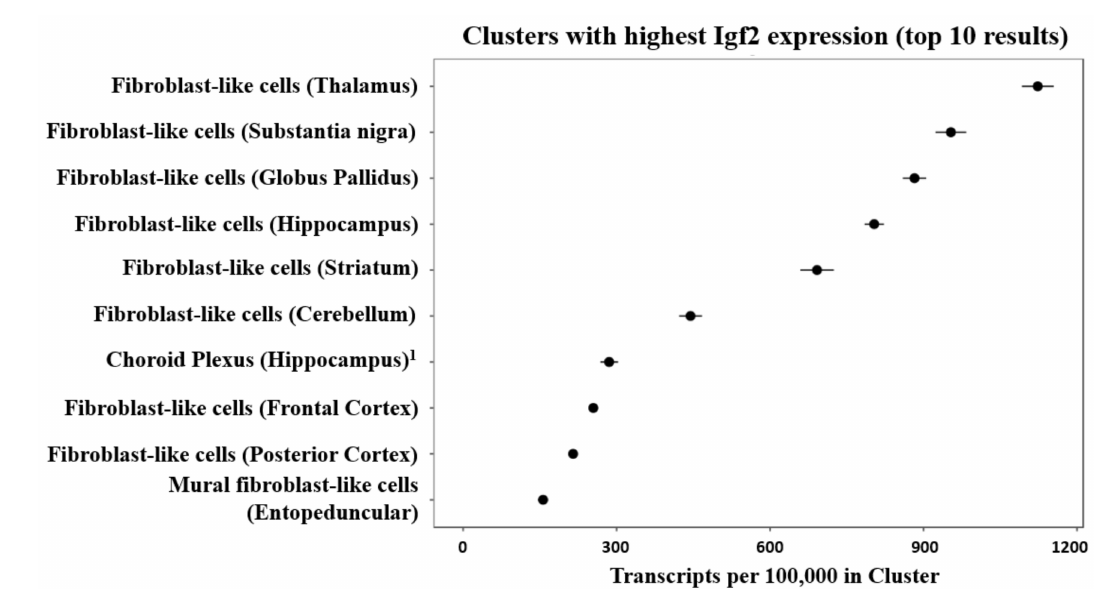
Figure 3. Cell clusters of the mouse brain showing the highest expression of Igf2 mRNA after single-cell sequencing from 9 mouse brain regions. The figure was generated by DropViz [68,69] and slightly modified. 1 It was noted that small fractions of choroid plexus were sampled from ventricle-adjacent regions including hippocampus